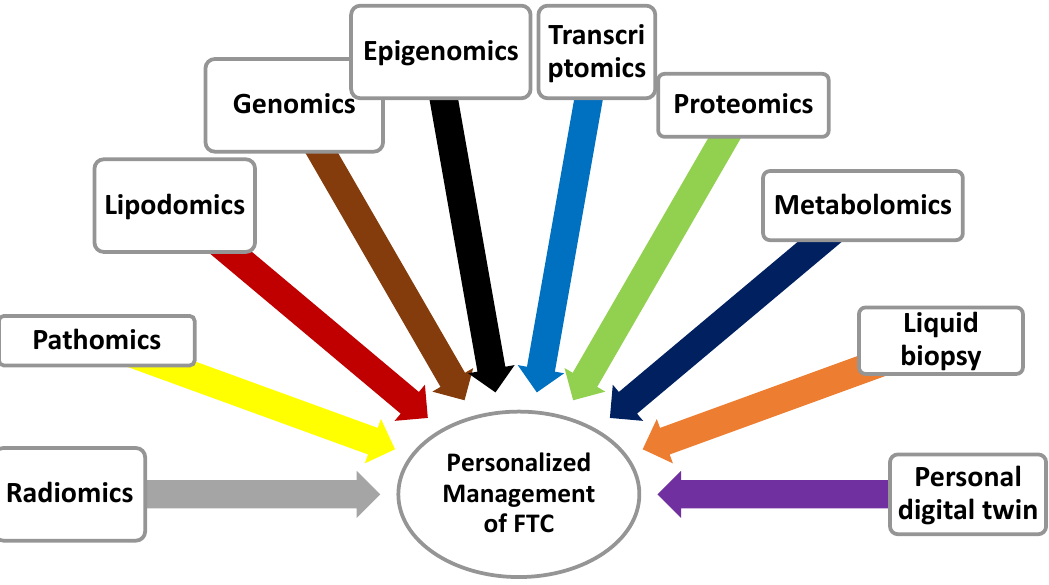
Figure 4. Components of the multi-omics that can be integrated and analyzed using the AI platform for computer-aided decision making in the management of FTC.